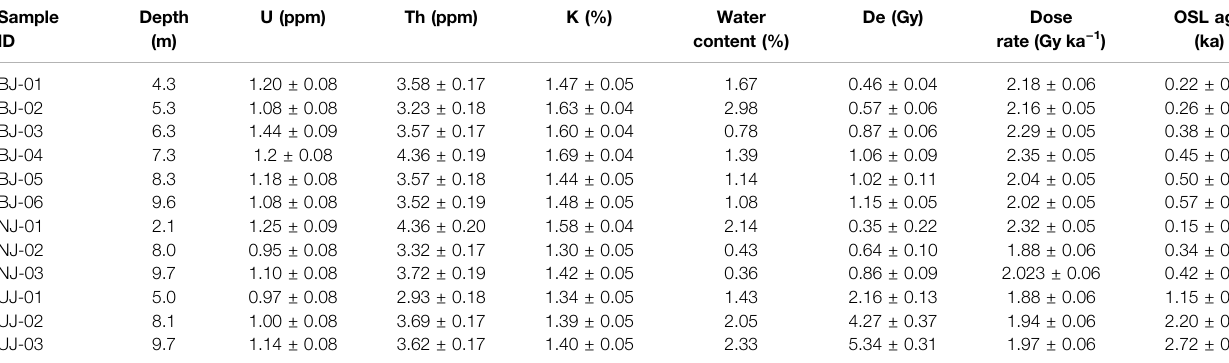
TABLE 2 | Environmental radioactivity and OSL dating results.